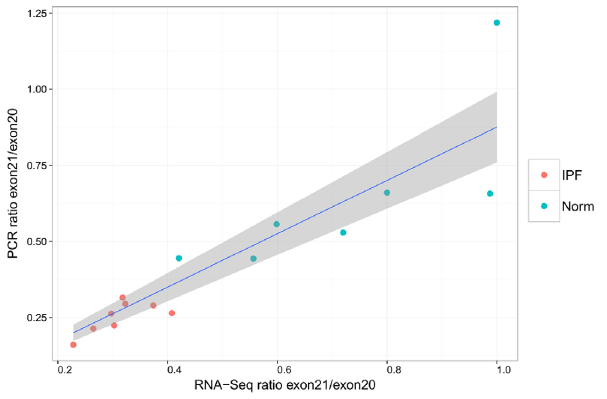
Figure 6. Ratios of periostin exon usage calculated from qPCR vs. RNA-Seq. The grey area indicates 95% confidence interval for the linear regression.